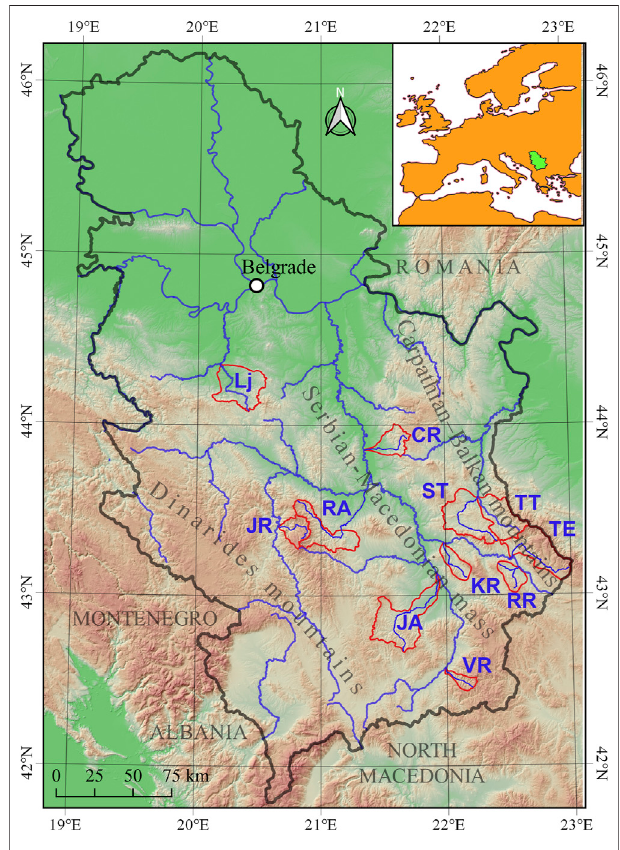
FIGURE 1 | Location of mountains watershed in Serbia.